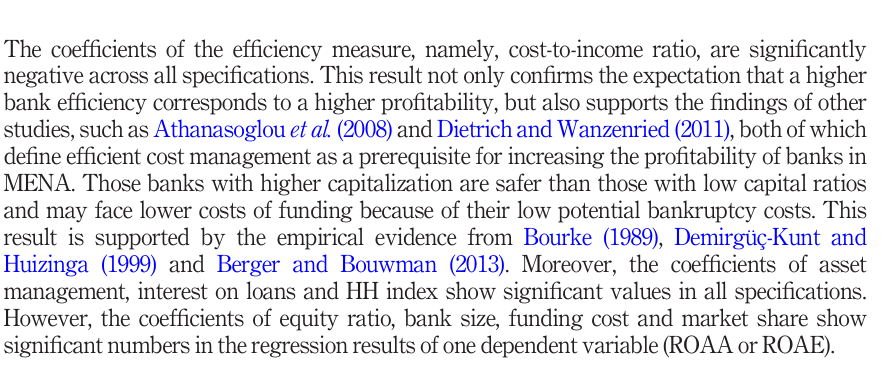
Table VI. Regression